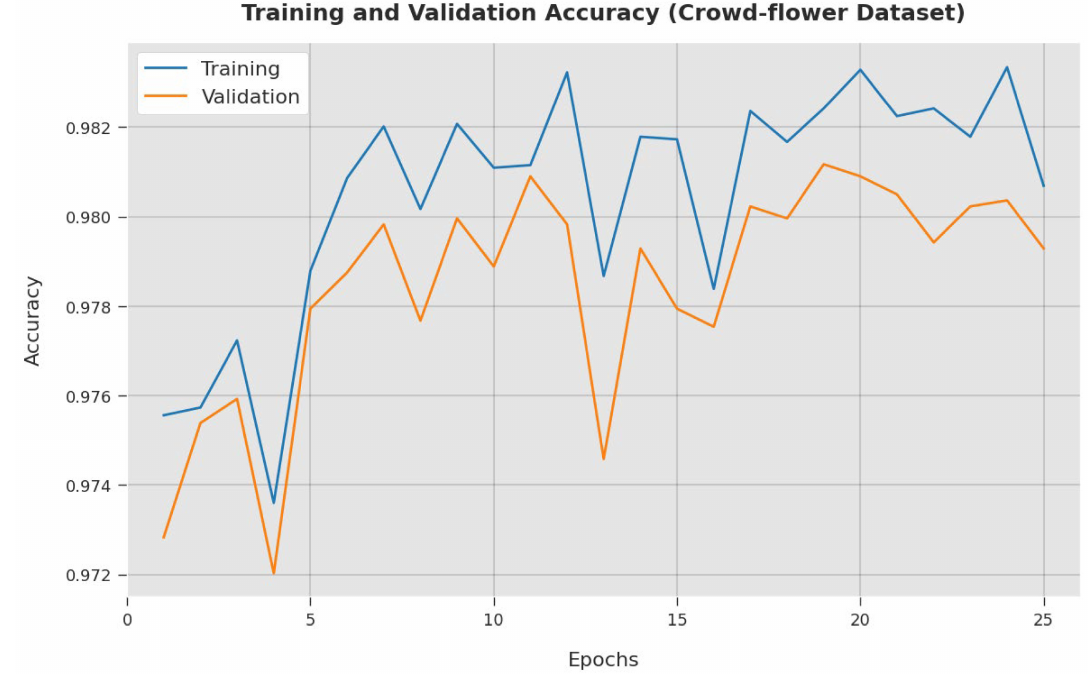
Figure 13. TA and VA analysis of ESGONLP-HSC algorithm under Crowd-flower dataset.